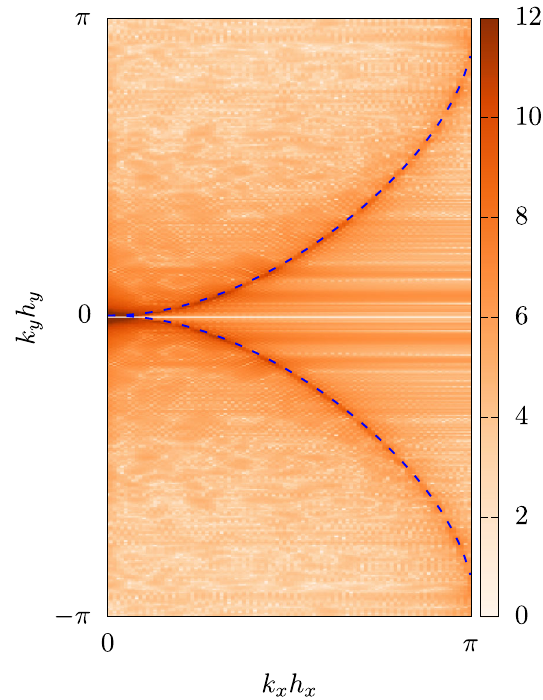
FIG. 3. Intensity of the spatial 2D FFT E y component for k ¼ 0 at time t=T ¼ 10 . The dashed line indicates the mode z b satisfying the dispersion relation for v ph ¼ c